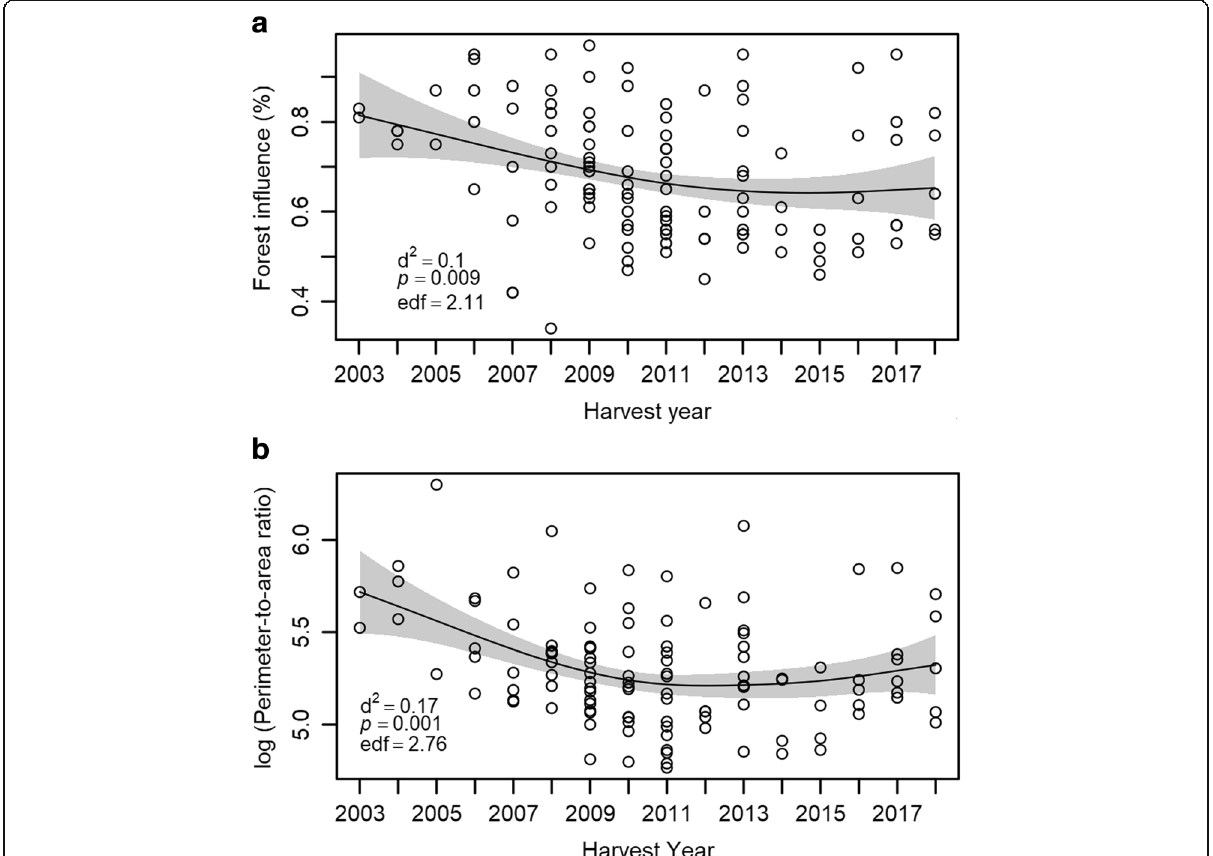
Fig. 3 Generalized additive models of the relationship between harvest year and a forest influence and b perimeter-to-area ratio in ARN coupes. Shaded areas indicate the 95% confidence interval. Perimeter-to-area ratio was log-transformed prior to modelling. d 2 is the proportion of the null deviance explained by the model. p values indicate the approximate significance of the single smooth term, while edf is the estimated degrees of freedom for the smooth